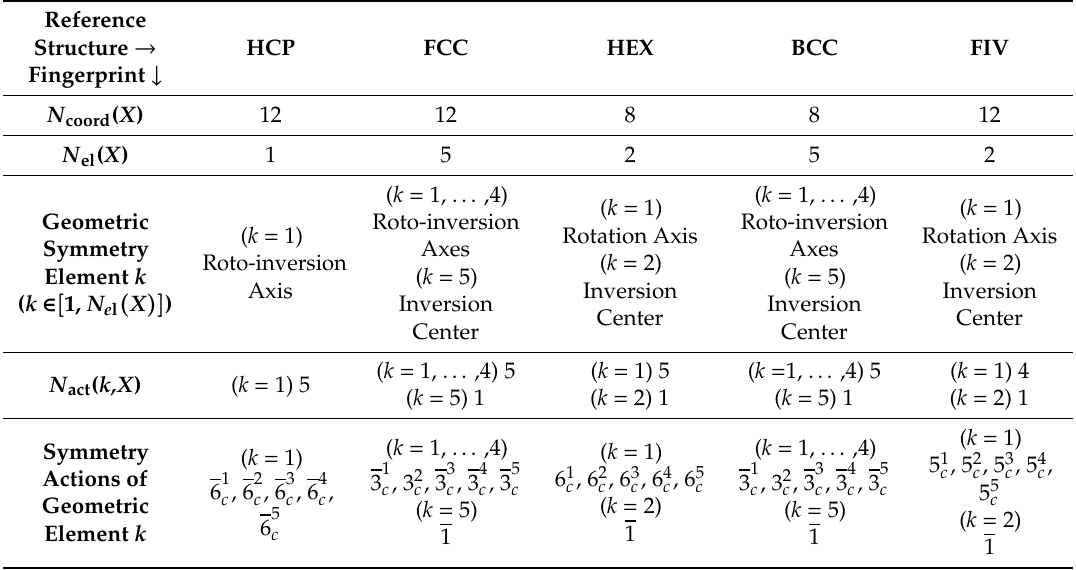
Table 1. Number of nearest neighbors, N coord ( X ), number of distinct geometric symmetry elements N el ( X ), along with their type, number of actions per element, N act ( k , X ) and their type for the 3-D crystals ( X = HCP, FCC, HEX and BCC) as well as the fivefold (FIV) local symmetry.